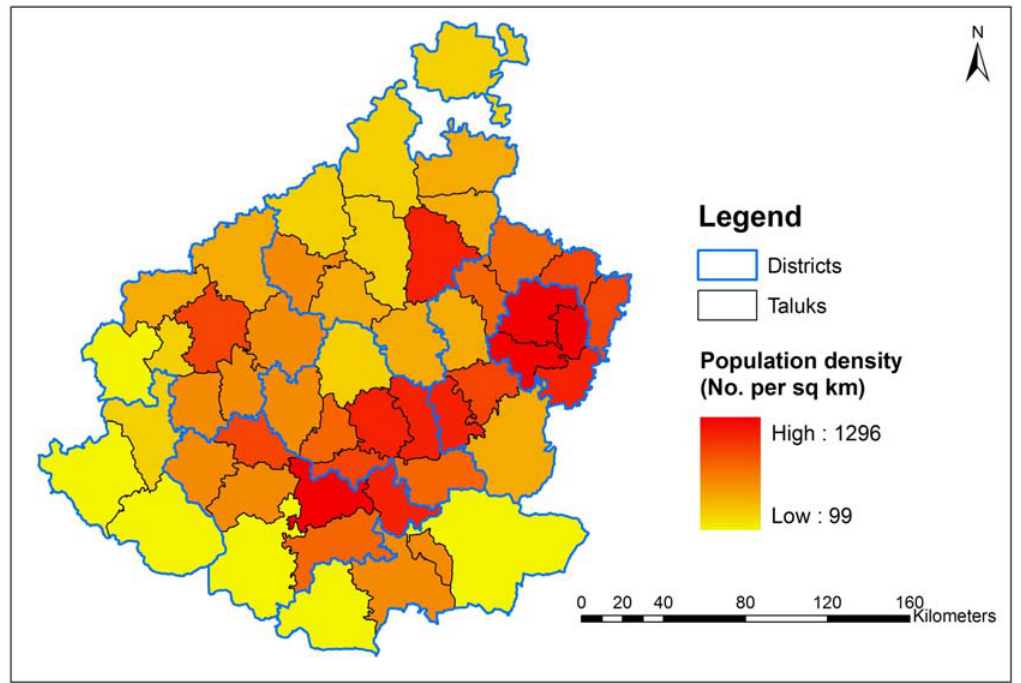
Figure 3. Population density distribution in study